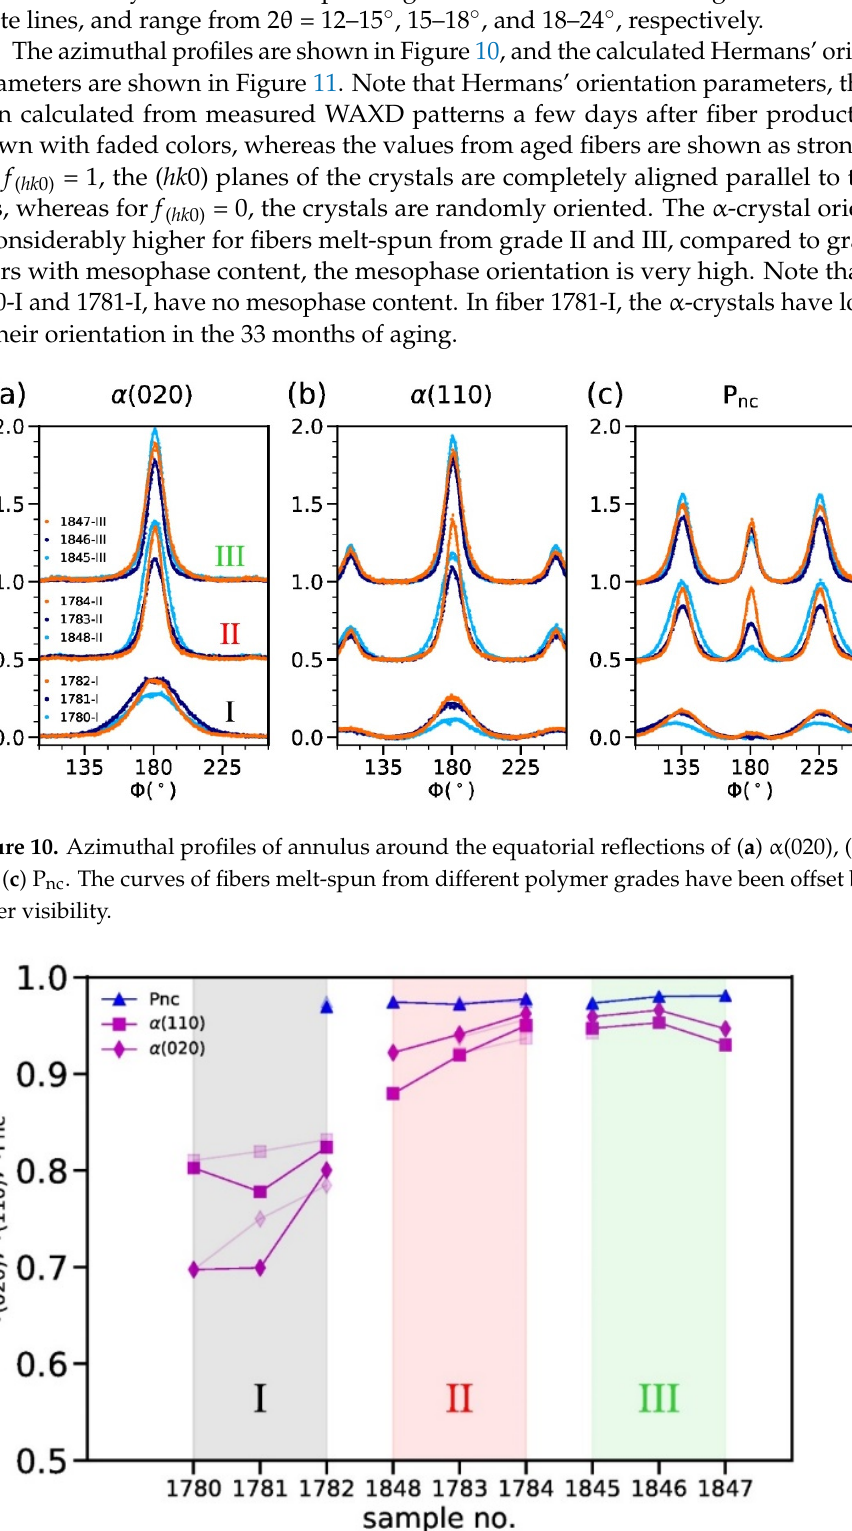
Figure 11. Hermans’ orientation factors as a function of the sample number for 33 months aged fibers. Shaded areas highlight the polymer grades I, II and III. Orientation factors extracted from WAXD patterns measured directly after spinning are shown with a faded color.